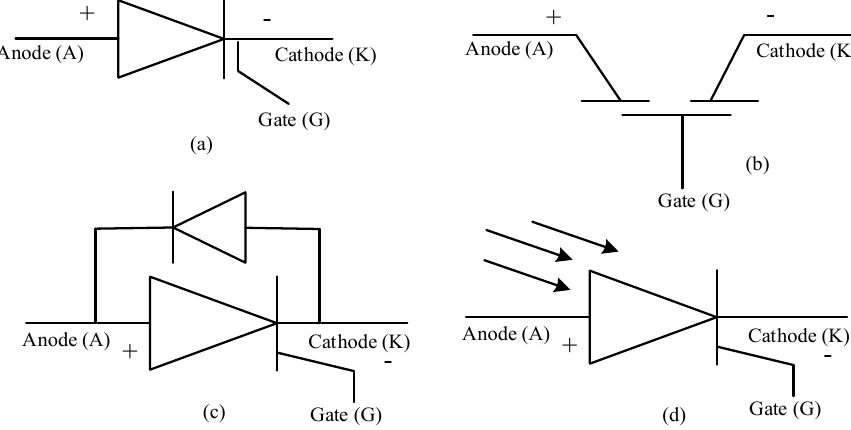
Figure 14. Schematic symbol of ( a ) a SITH, ( b ) an MCT, ( c ) an RCT and ( d ) an LASCR [140].